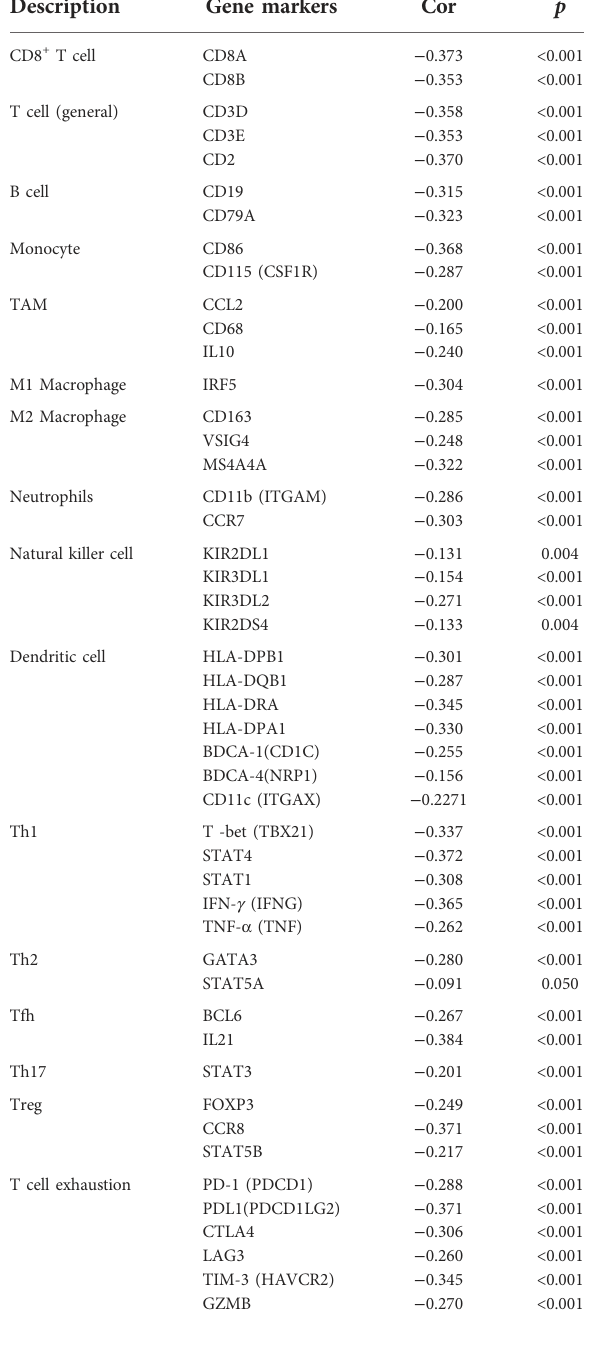
TABLE 4 Correlation analysis between ITGAL and related genes and markers of immune cells in Xiantao tool.